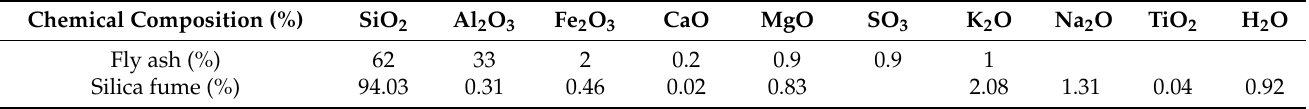
Table 1. Composition content of fly ash and silica fume.